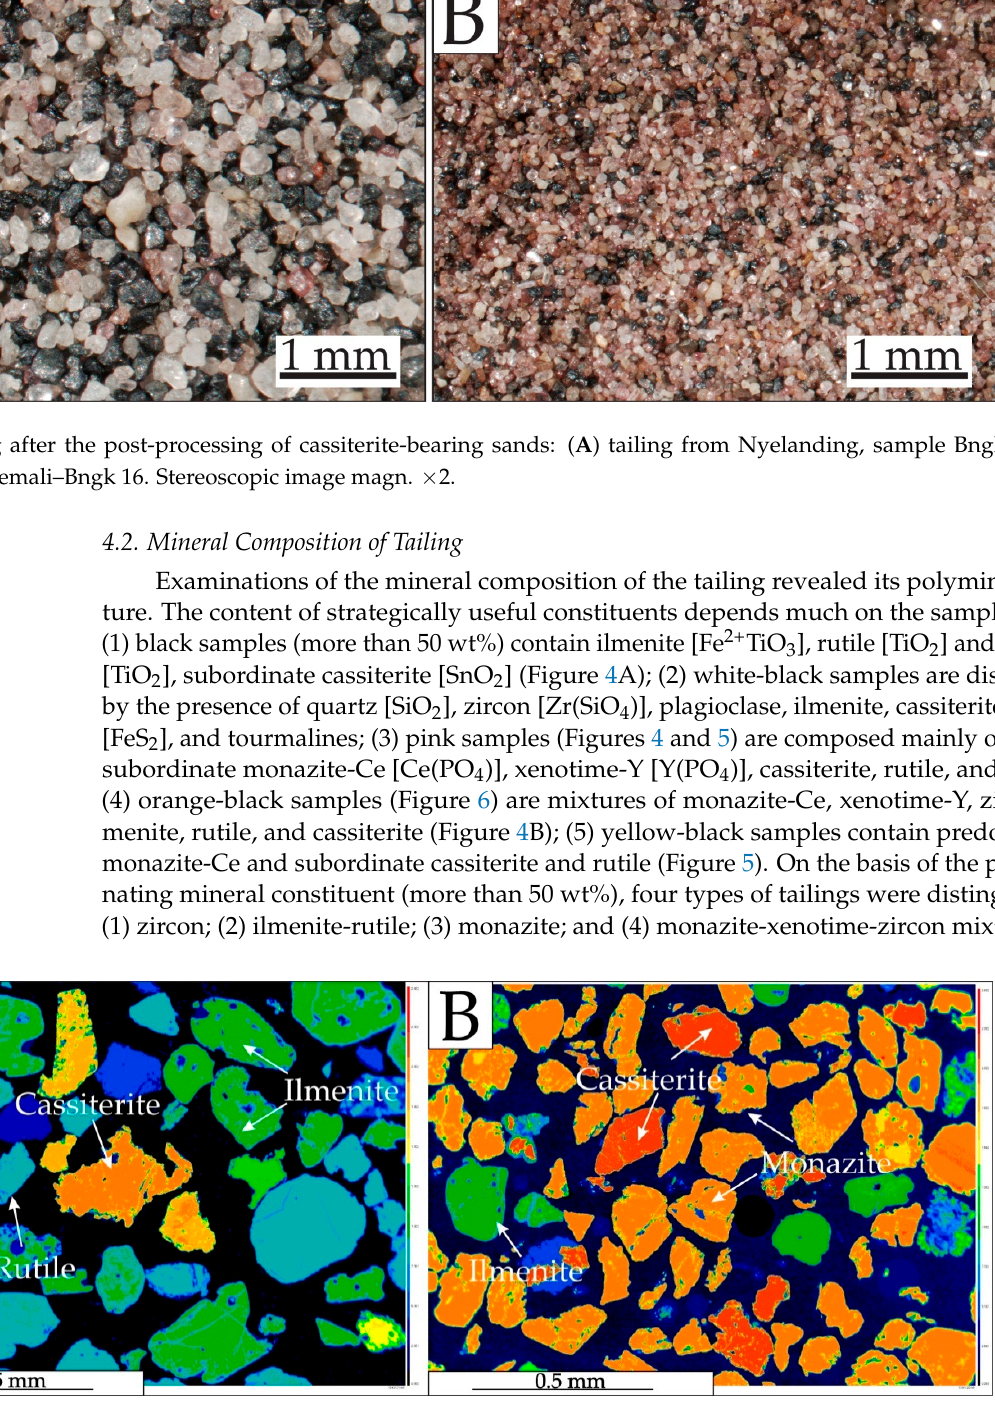
Figure 4. Mapping of minerals using SEM-BSE: ( A ) Ilmenite-rutile tailing (Sample Bngk 27); ( B ) monazite tailing (Sample Bngk 21).